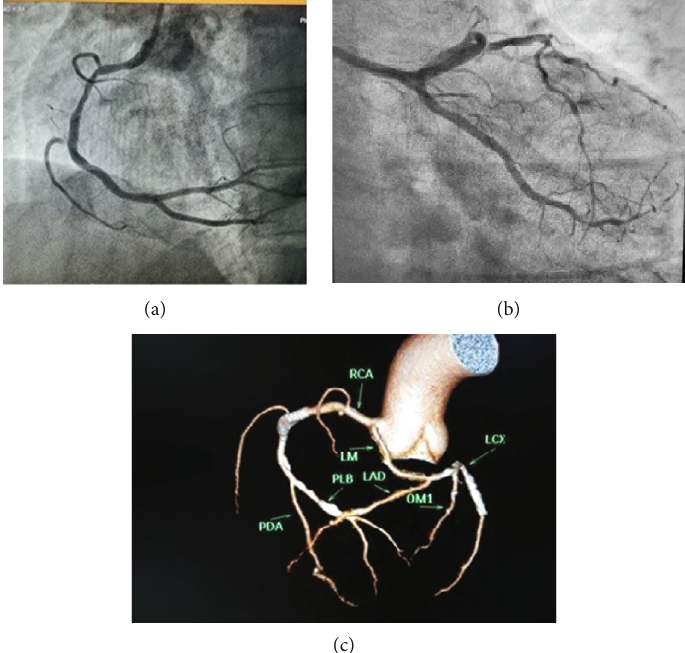
Figure 2: (a) Post-PCI image of RCA showing coronary spasm just proximal to RCA stent after postdilatation. (b) Post-PCI angiogram of LCX. (c) Coronary computed tomography angiography done prior to discharge, delineating the origin and the course of the anomalous artery and patent stents. PCI: percutaneous coronary interventions; RCA: right coronary artery; LCX: left circum fl ex